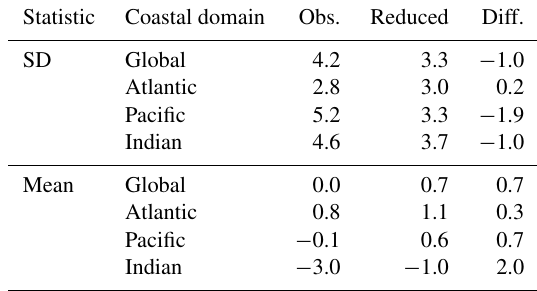
Table 2. Statistics of the global–coastal sea-level trend from 2008– 2018 observed by satellite altimetry and when reduced by the recon- structed sea level expected from the climate index reconstruction for each basin (mmyr − 1